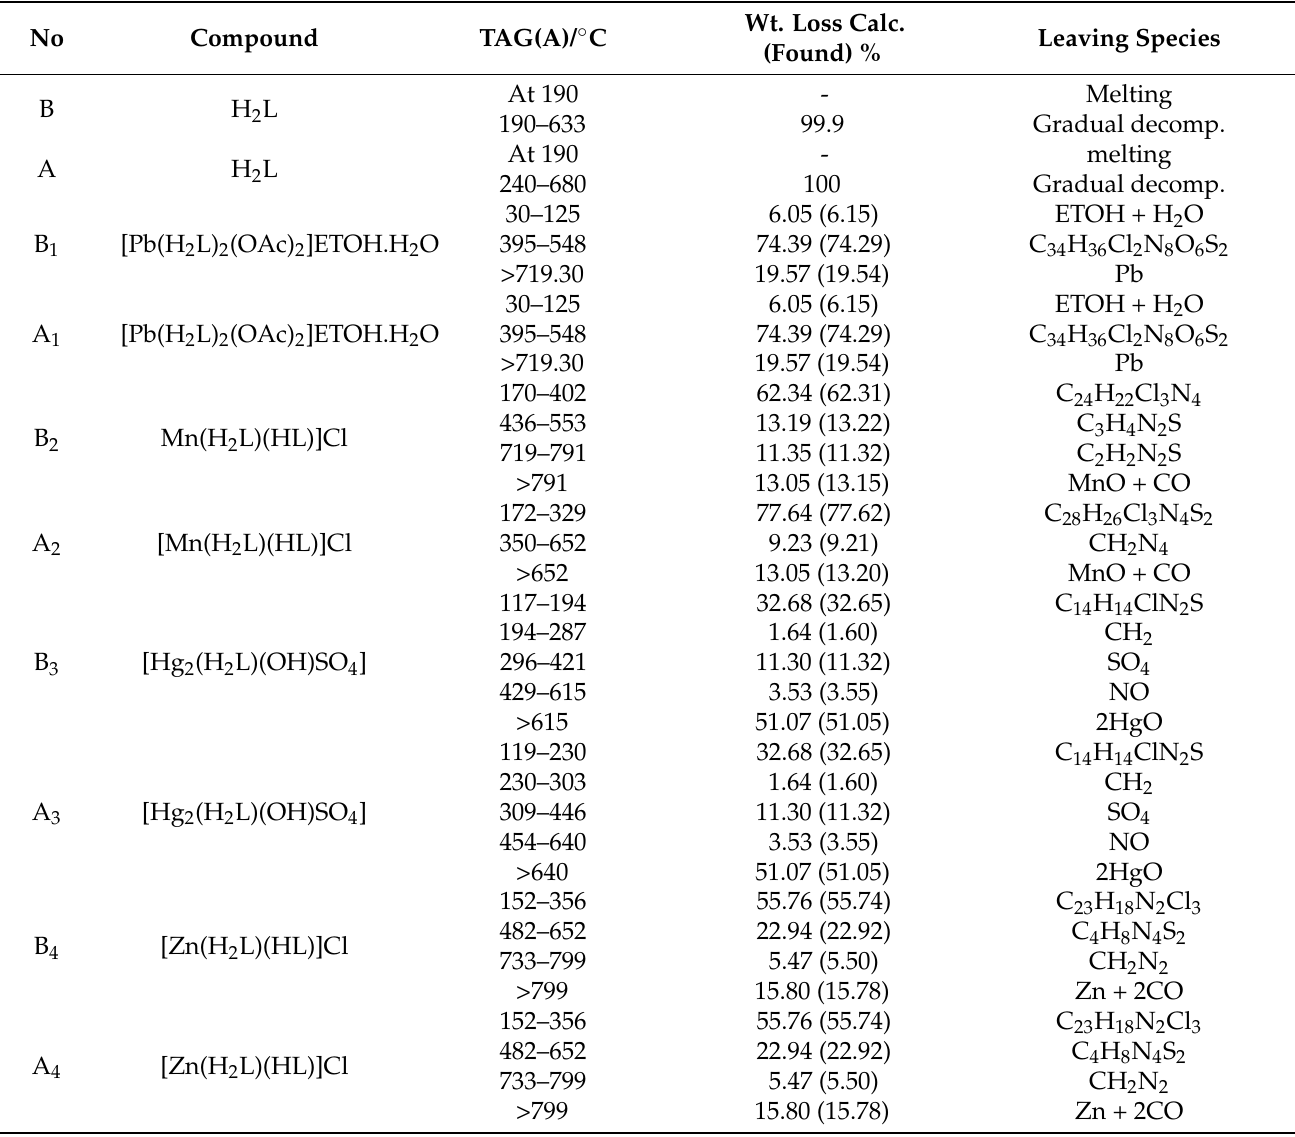
Table 5. Thermal data of the ligand and its metal